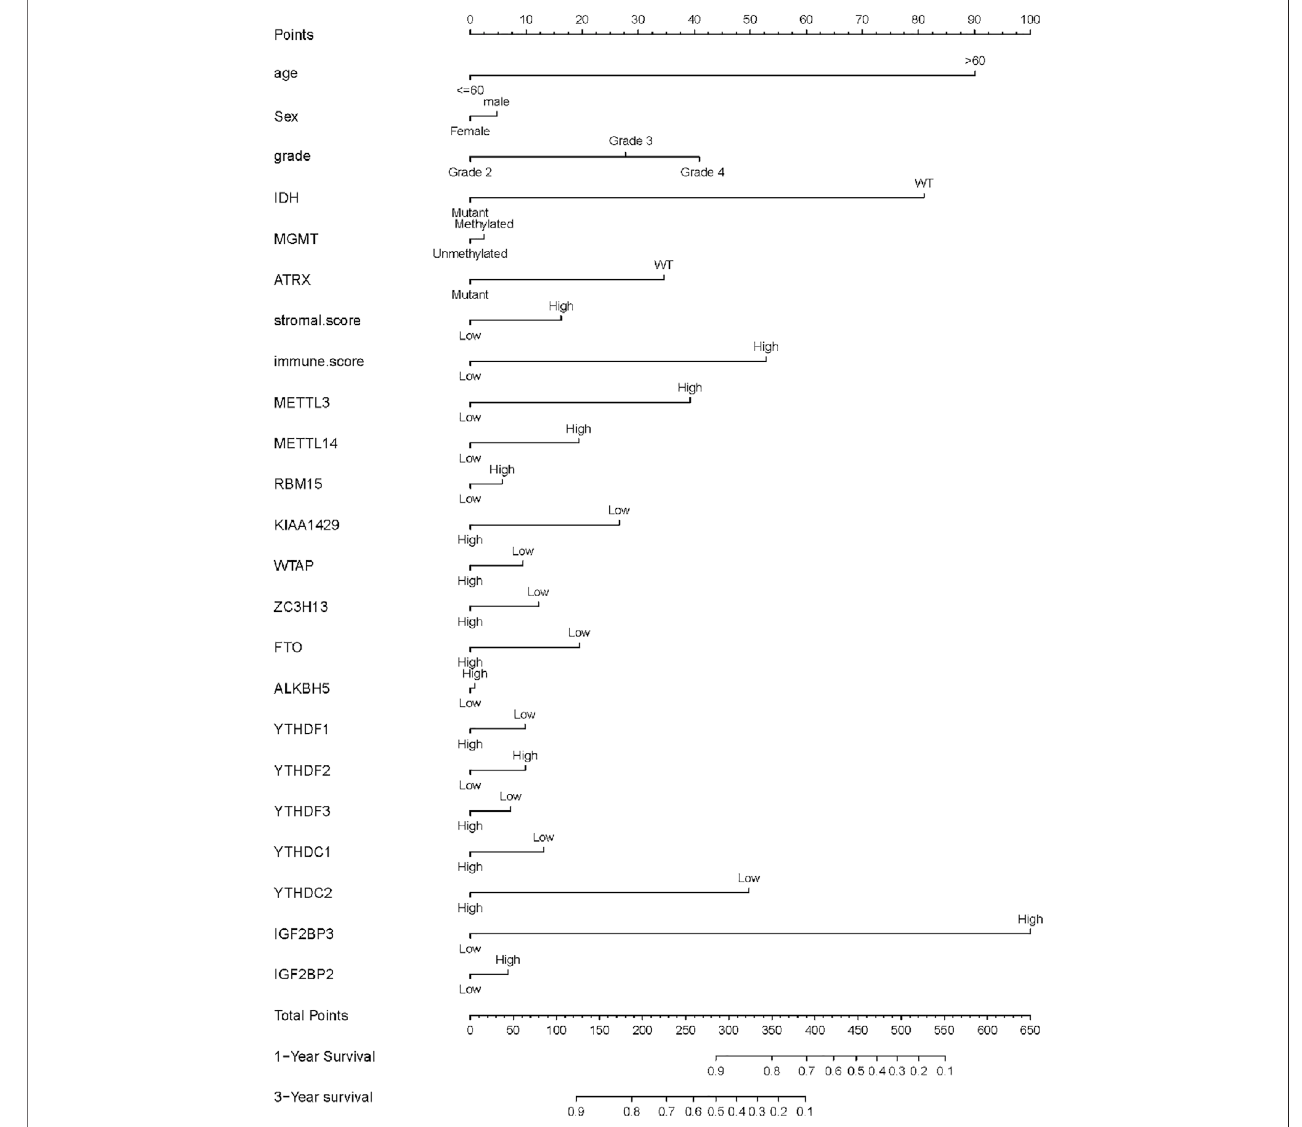
FIGURE5| Gliomasurvivalnomograms.Forusingthenomograms,thevalueforanindividualpatientislocatedoneachvariableaxis,andalineisdrawnupwardto determine the number of points received for each variable value. The sum of these numbers is located on the Total Points axis, and a line is drawn downward to the survival axes to determine the likelihood of 1- or 3-years